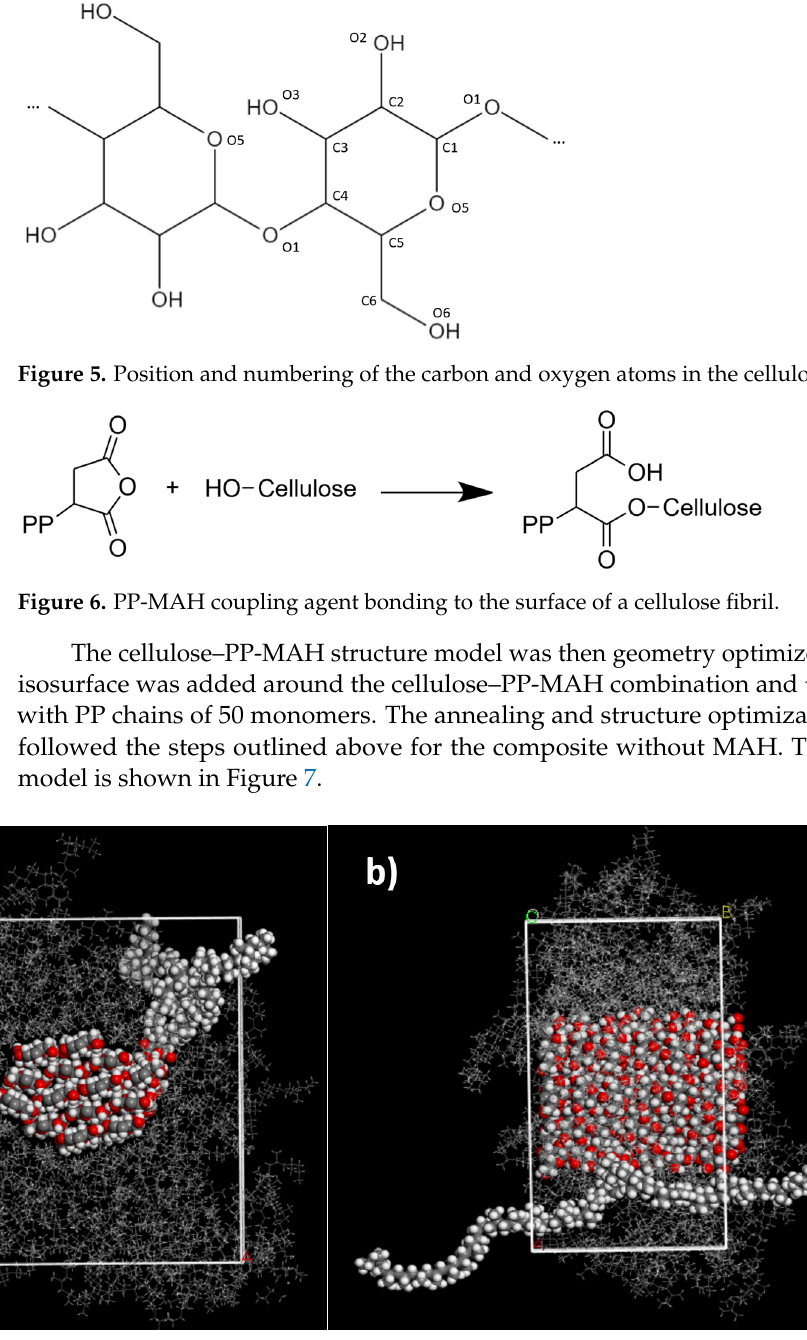
Figure 7. ( a ) Front view and ( b ) side view of 20 m-% cellulose PP-MAH composite (simulation box